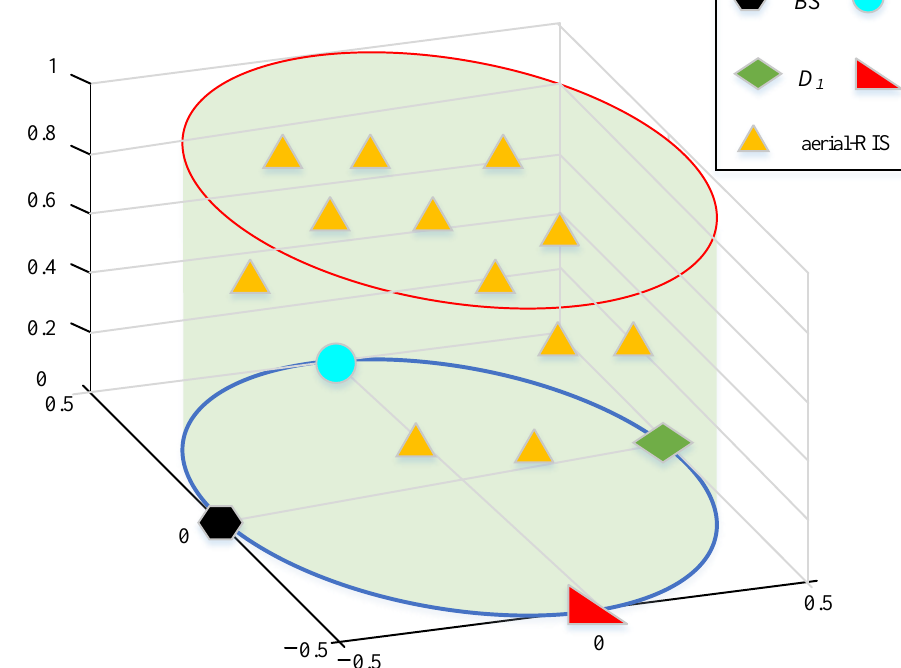
Figure 2. Motion morphology of Aerial-RIS in such RIS-NOMA